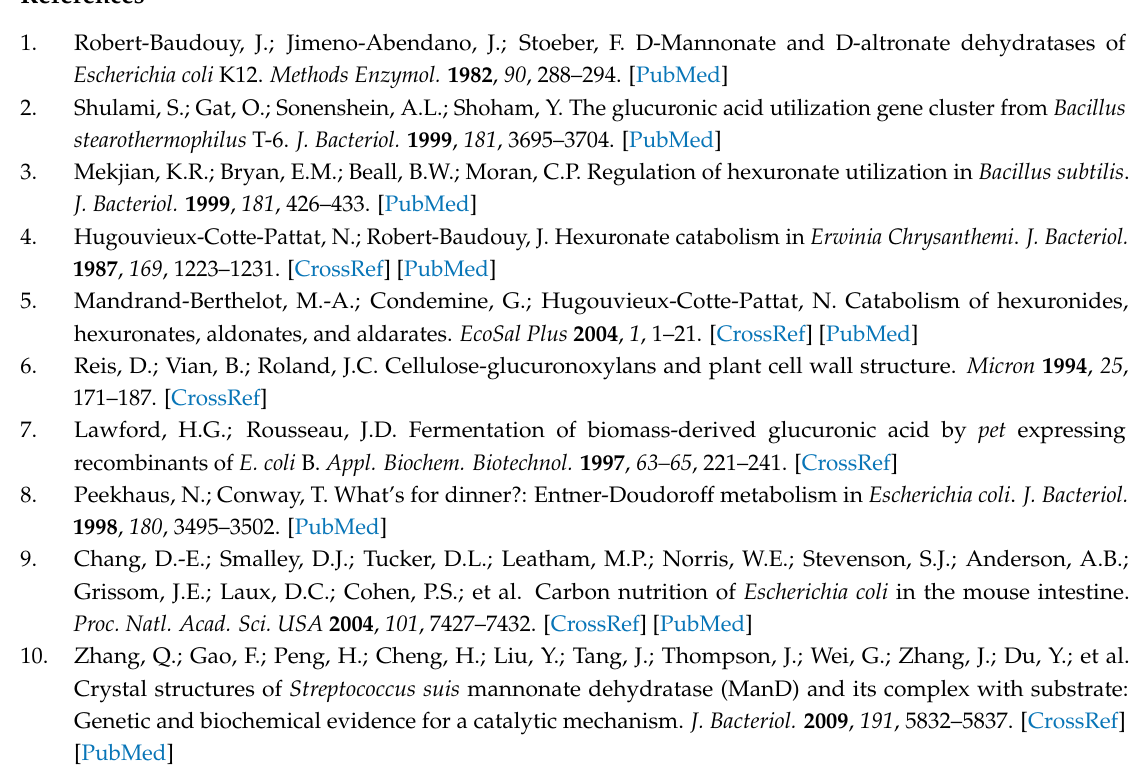
Figure S1: Purification of the Ta0753 gene product (TaManD) after expression in E. coli , Figure S2: TaManD kinetic data Table S1: Overview of genes, potentially encoding for mannonate dehydratases located in the genomic neighbourhood of AldT (Ta0754), Table S2: Oligonucleotides used in this